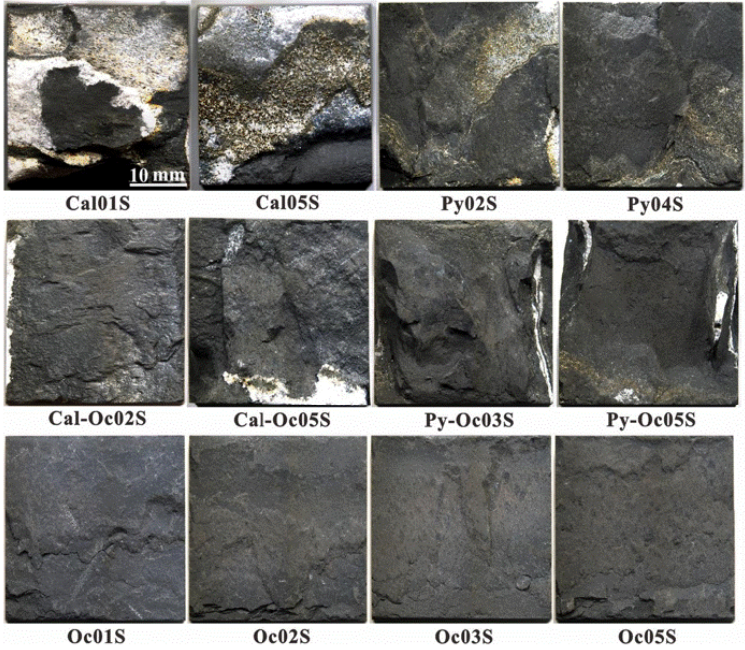
Figure 9. Failure morphology of shale specimen with various laminae after the angle-varied plate shear test.